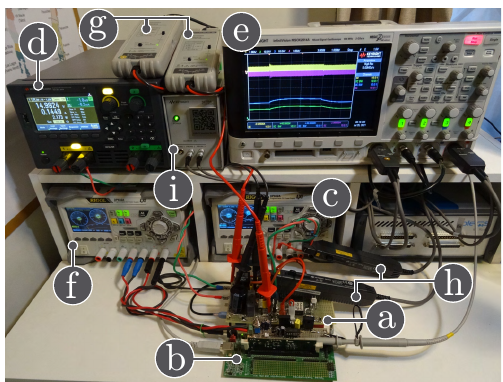
Figure 14. Experimental setup: ( a ) reconfigurable power converter, ( b ) digital signal controller, ( c ) input dc power supply, ( d ) dc electronic load in constant resistance mode of 100 Ω , ( e ) oscilloscope, ( f ) auxiliary power supply, ( g ) voltage differential probes, ( h ) current probes, ( i ) power supply for the current